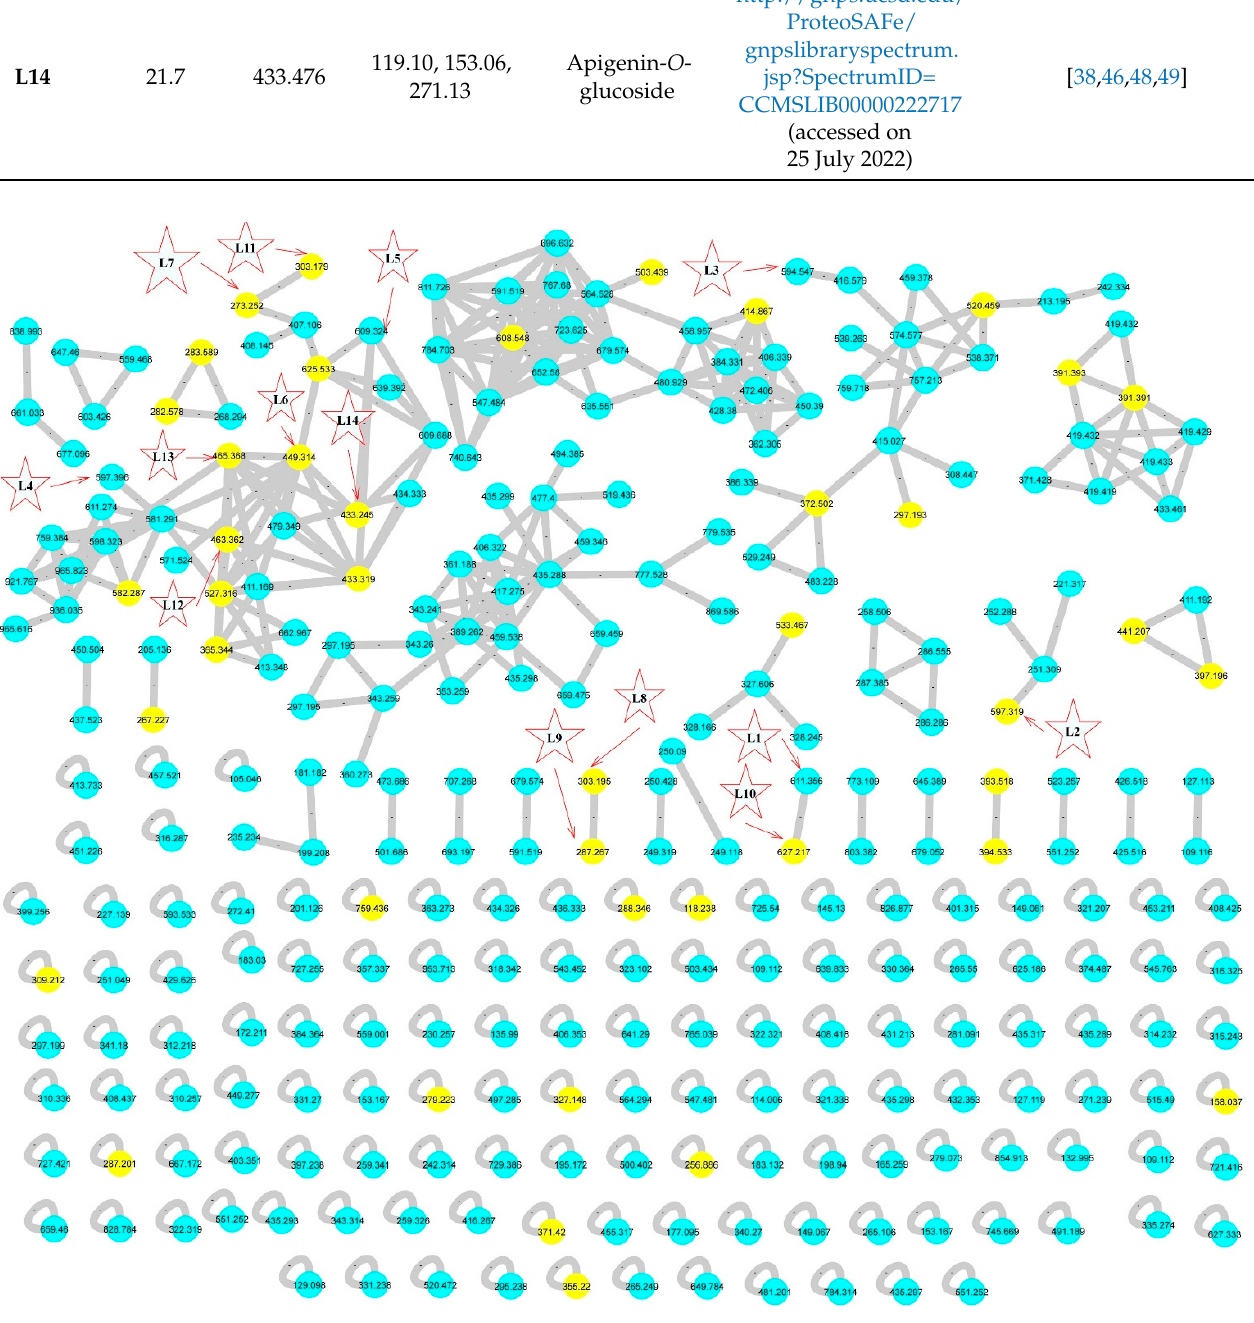
Figure 1. A. hierochuntica metabolite parent mass molecular network. The blue circular nodes refer to all metabolite parent masses revealed from raw mass spectra. The yellow ones are for the metabolites that were identified by the GNPS library. Seven of the flavonoids were verified by literature comparison, and the remaining ones were manually identified (L1-L14).